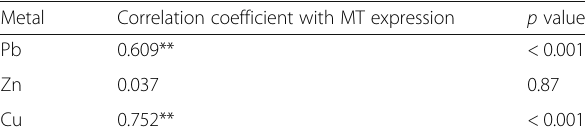
Table 5 Pearson correlation between hepatic MT expression levels and metal concentrations in fish in different seasons Metal Correlation coefficient with MT expression